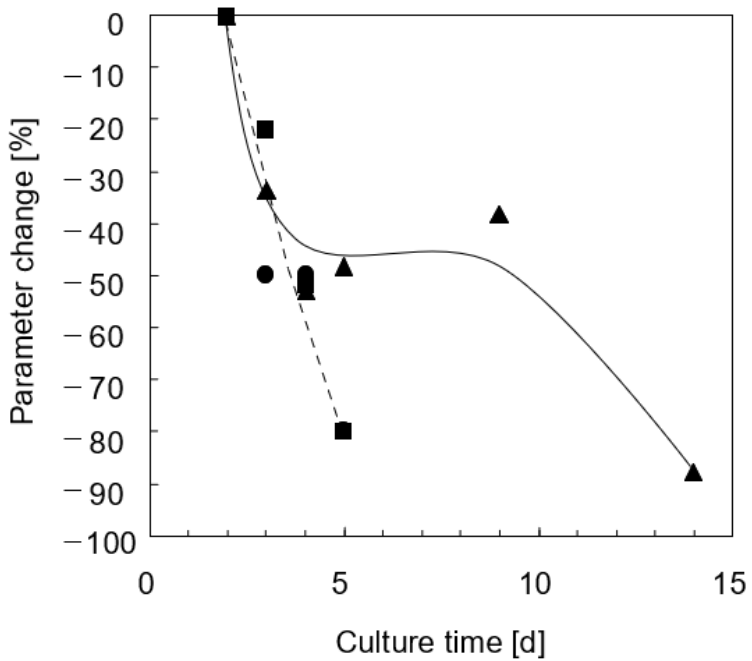
Figure 5. Time decay during culture of the transformation kinetic constants with adherent cells: ( ▲ ) k 1,L,A for lidocaine elimination; ( ⚫ ) k 1,M,A for MEGX formation; ( ◼ ) k 2,A for MEGX further trans- formation. ‒